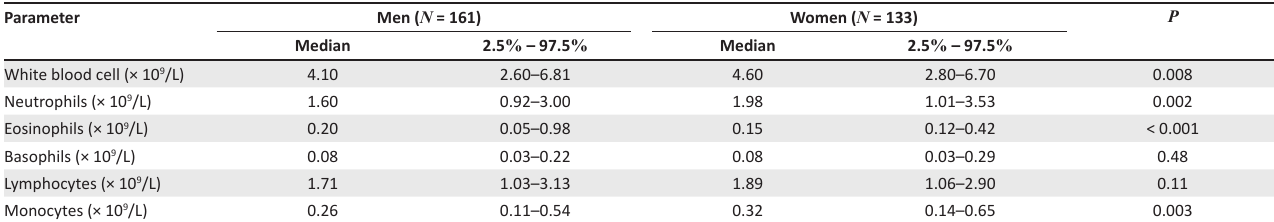
TABLE 5: White blood cell parameters for men and women, Yaoundé, Cameroon, November 2015 – September 2016. Parameter